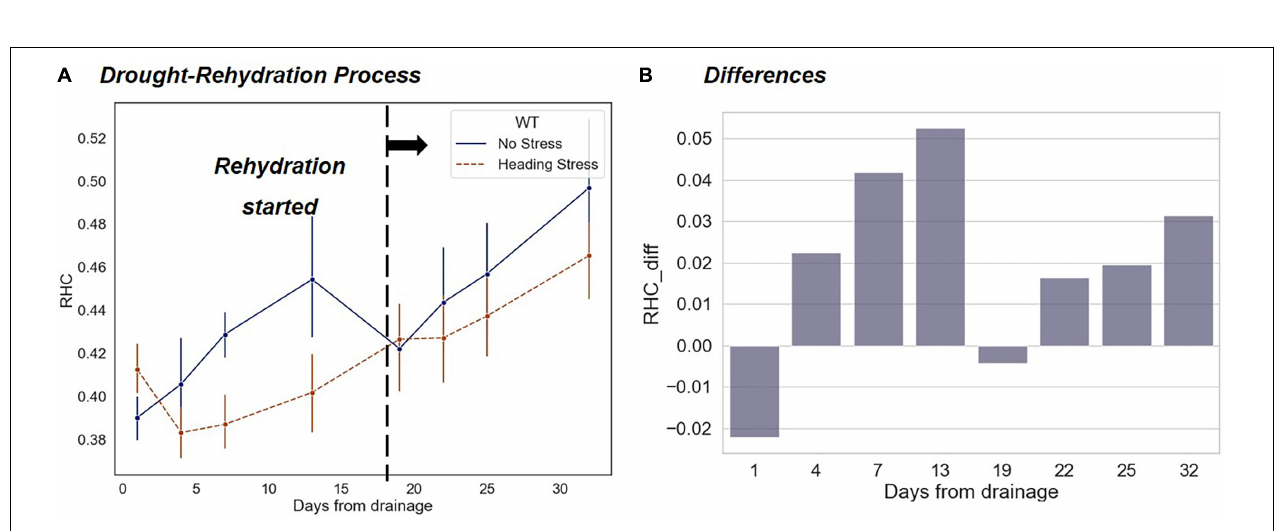
FIGURE 11 | Changing trends of RHC indicators under short-term drought-rehydration during the heading and filling stage. (A) Comparison of changes between the HS and WF groups over 32 days after drought beginning. (B) Changes in RHC differences between the HS and WF groups.